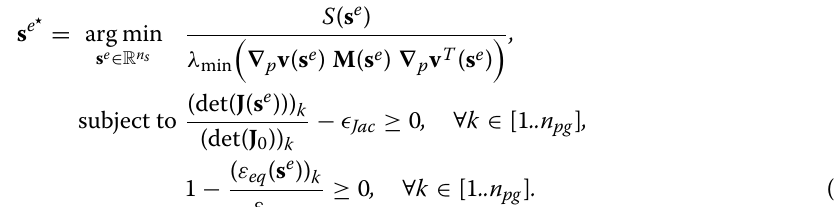
where( ε eq ) k istheequivalentstrainvalueattheGausspoint k and ε max isagiventhreshold. In this study, the Von Mises equivalent strain was chosen